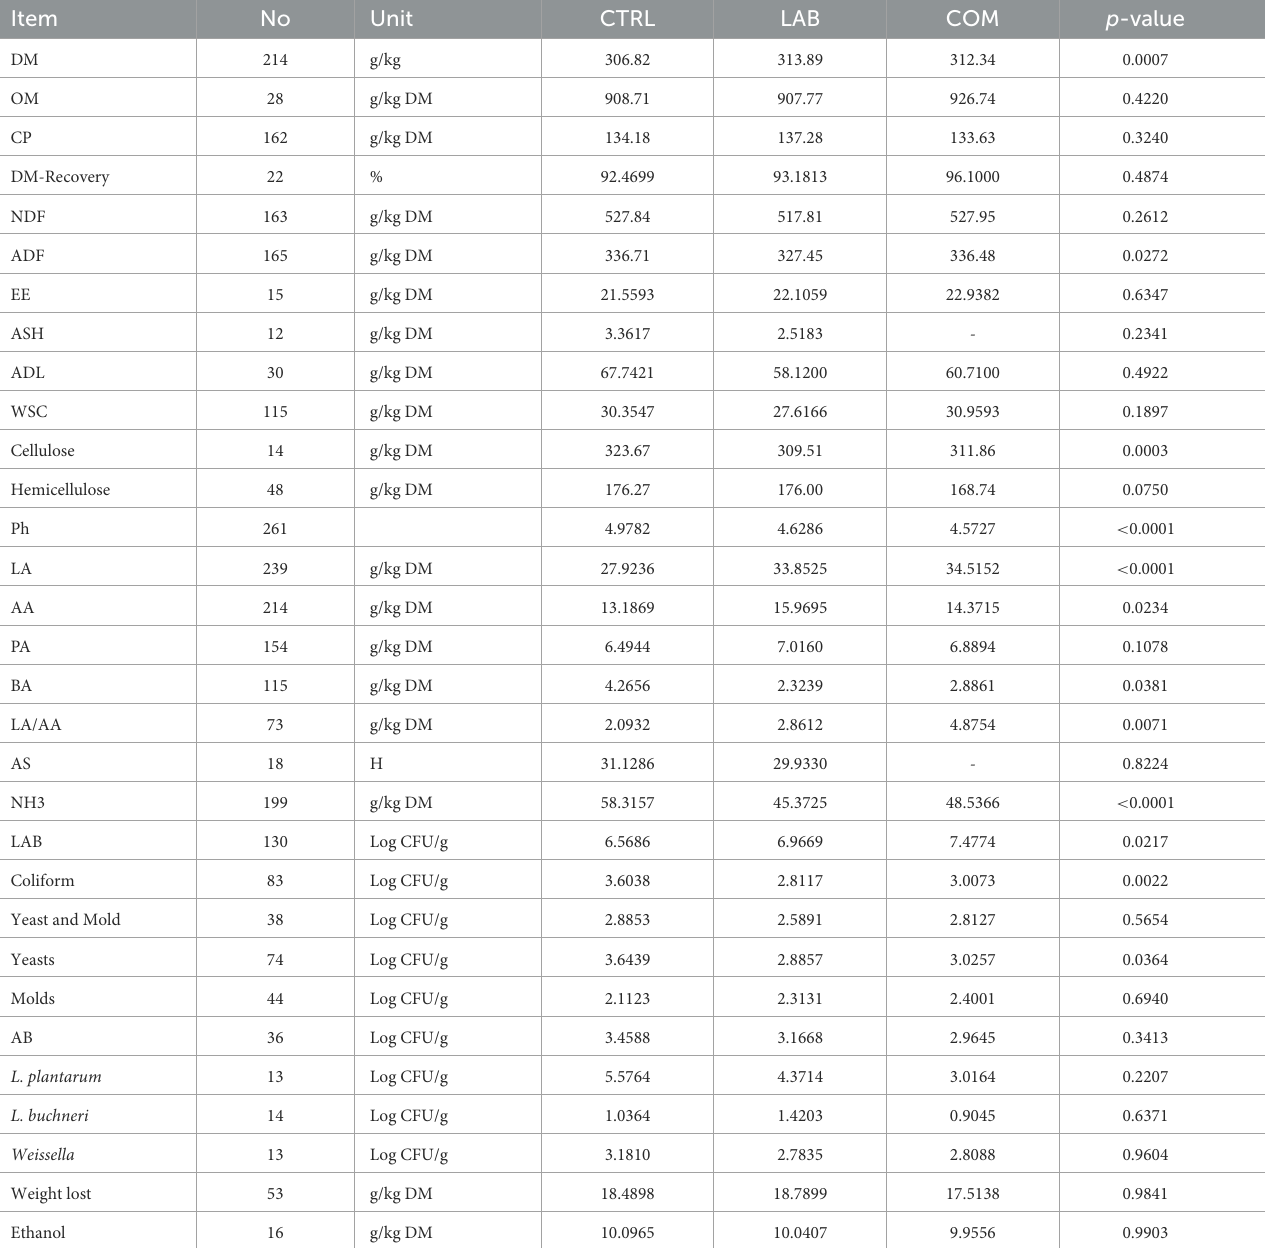
TABLE 6 Effects of lactic acid bacterial types on the chemical composition and silage